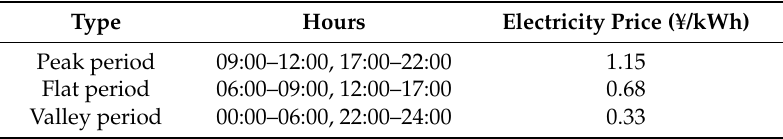
Table 3. Time-of-use electricity price.